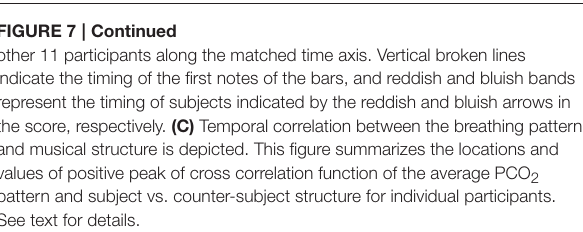
FIGURE 7 | Continued other 11 participants along the matched time axis. Vertical broken lines indicate the timing of the first notes of the bars, and reddish and bluish bands represent the timing of subjects indicated by the reddish and bluish arrows in the score, respectively. (C) Temporal correlation between the breathing pattern and musical structure is depicted. This figure summarizes the locations and values of positive peak of cross correlation function of the average PCO 2 pattern and subject vs. counter-subject structure for individual participants. See text for